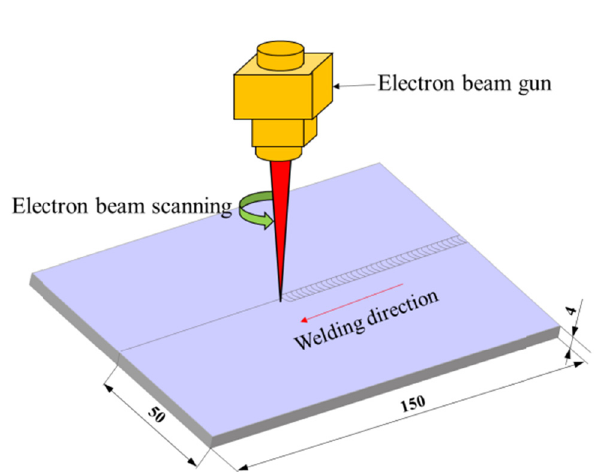
Figure 1: Schematic diagram of EBW